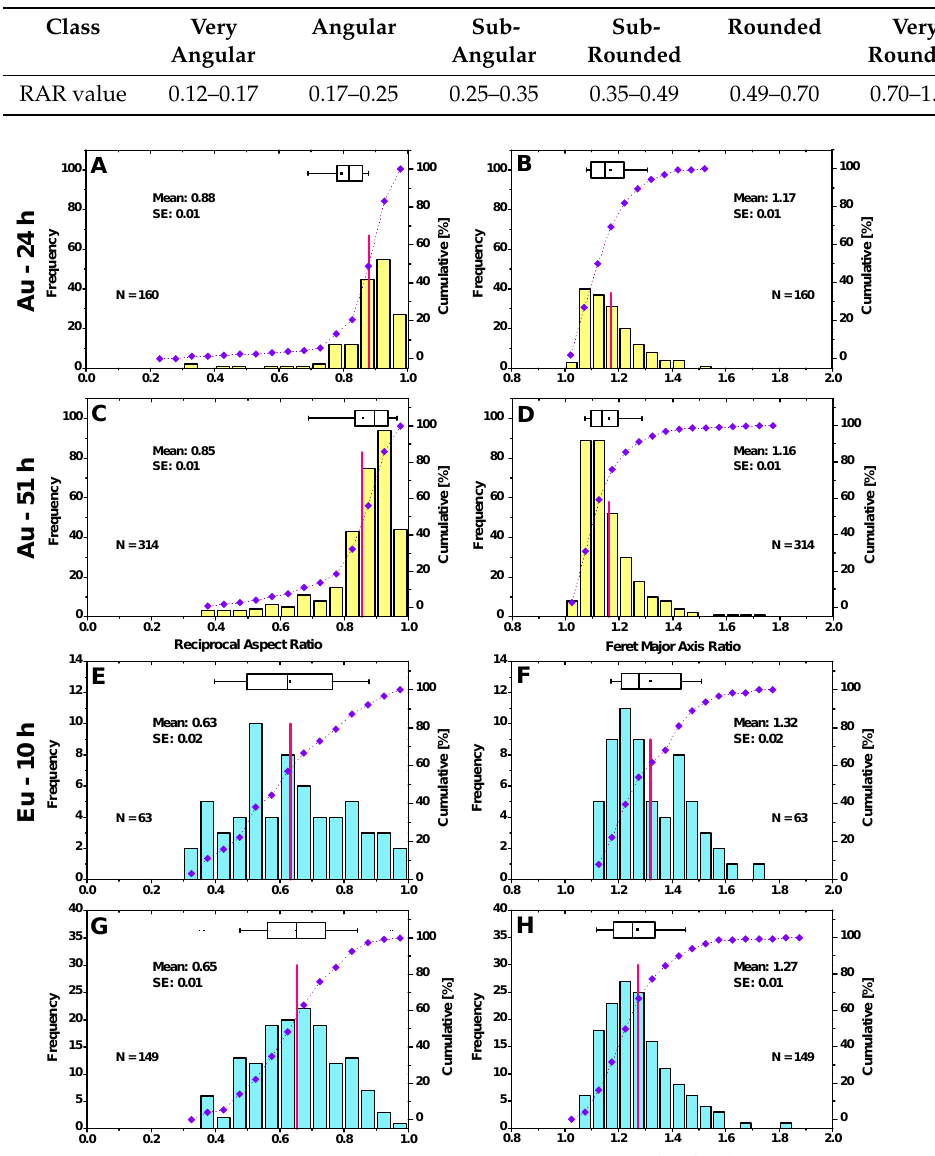
Figure 5. Shape classification for Au-NPs after 24 h ( A , B ) and 51 h ( C , D ) and for Eu after 10 h ( E , F